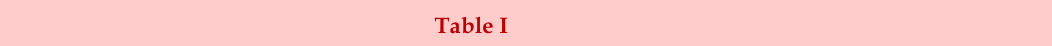
Dose dependent larvicidal and ovicidal activity of aqueous extract of Calotropis procera leaves Cx. Tri- taeniorhynchus and Cx. gelidus Mosquitoes species